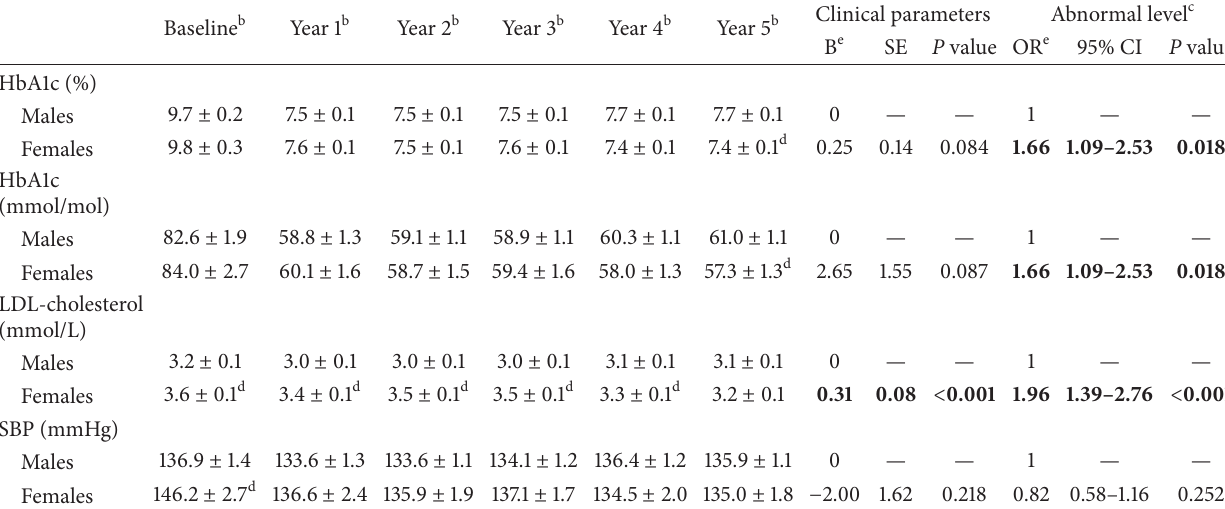
a The longitudinal data were described only up to year 5 of the observation period, in which the sample size was sufficiently large to calculate the mean and SE values for the metabolic profiles. b Data are presented as means ± SE. c